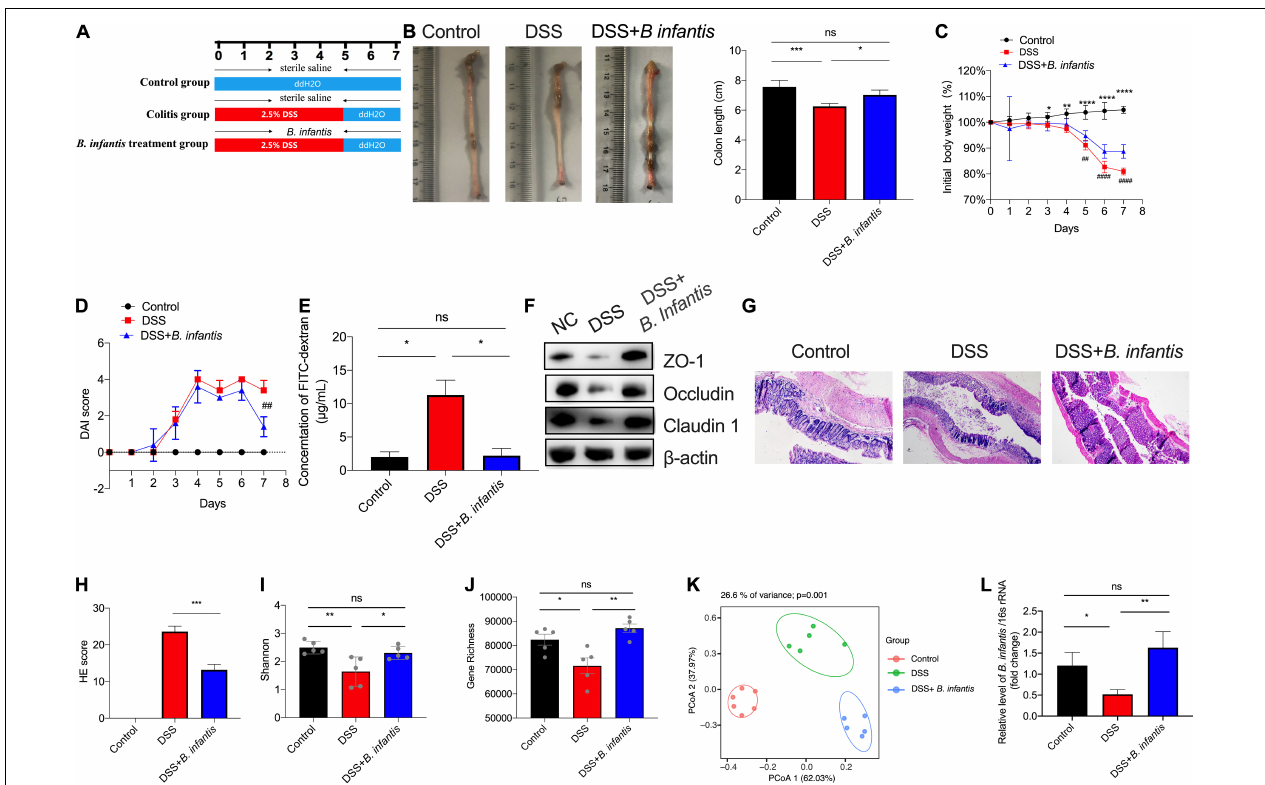
FIGURE 3 | The administration of B. infantis relieved colitis in a dextran sodium sulfate (DSS) mouse model of acute colitis. (A) Schema of DSS-induced colitis model. Mice in the control group and the colitis model group were pretreated with sterile saline, and the B. infantis treatment group was pretreated with B. infantis for 7 days. Then, DSS treated mice receiving B. infantis by oral gavage as indicated; mice were sacrificed on day 8 and colon length was measured (B) . (C) Body weight of mice in each group was measured during the experiment period. *Control vs. DSS p < 0 . 05, **Control vs. DSS p < 0 . 01, *****Control vs. DSS p < 0 . 0001, ## Control vs. DSS + B. infantis p < 0 . 01. (D) DAI score was monitored each day during the experiment period. ## control vs. DSS + B. infantis p < 0 . 01. (E) The FITC assay was performed to determine intestinal permeability. (F) The expression levels of tight junction components, including ZO-1, Claduin-1, and Occludin, were detected by western blot assays. H&E staining of sections (G) and the total histological score (H) . (Magnification, × 20.) (I–K) The Shannon index (I) , gene richness (J) and Principal Coordinates Analysis (PCoA) plot of Bray–Curtis (K) regarding to the gut microbiota in DSS-treated models using metagenomic sequencing. (L) The level of B. infantis in feces of DSS-induced model detected by qRT-PCR assay. Results represent mean ± SEM; * p < 0.05, ** p < 0.01, *** p < 0.001, **** p < 0.0001, ns, no